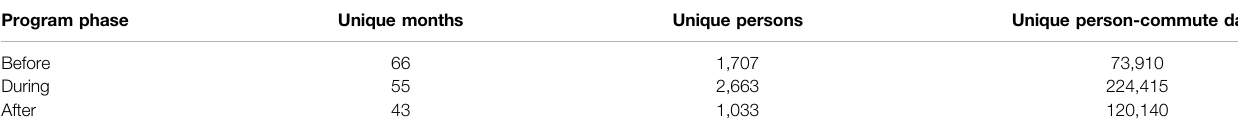
TABLE 1 | Sample size by evaluation